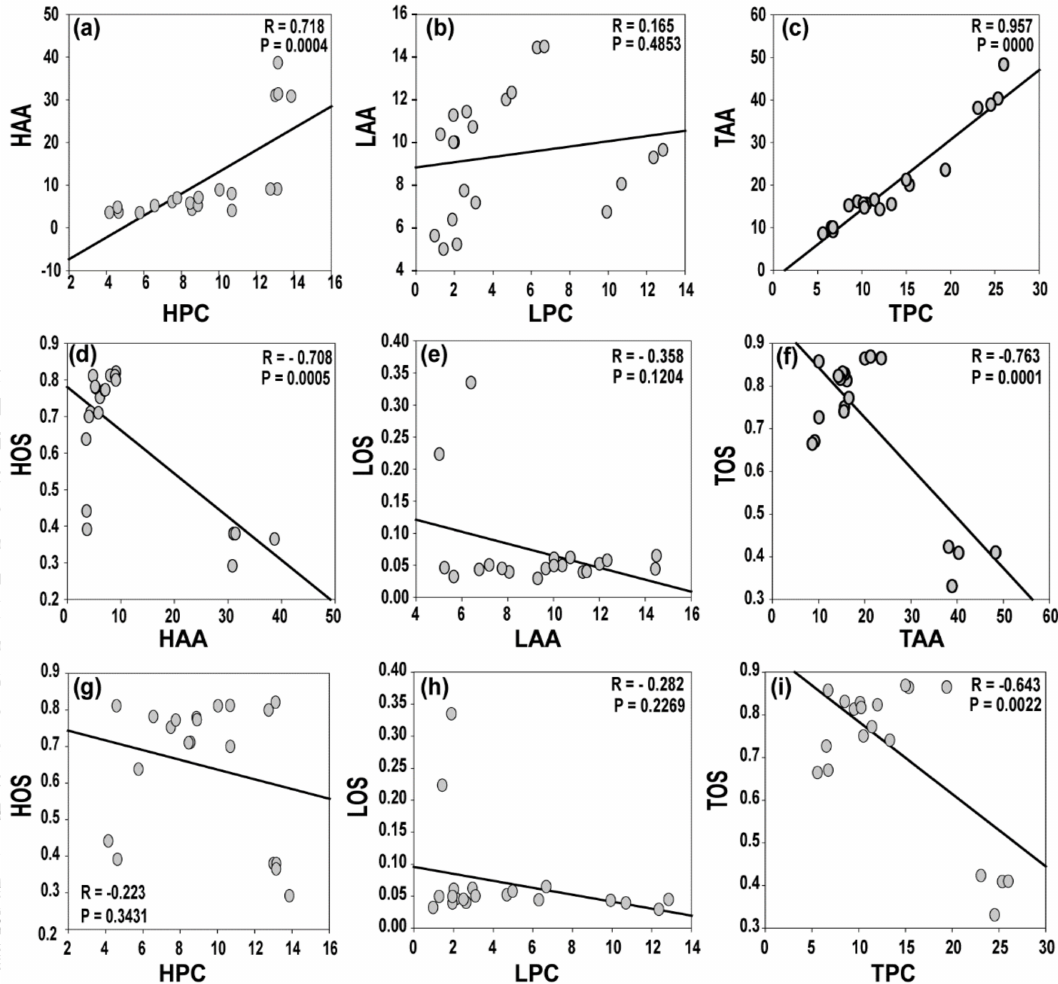
Figure 6. Scatter plots showing relationships between the phenolic content and antioxidant activities in natural soaps formulated with wild berry extracts following cold saponification ( a – c ). Scatter plots showing relationships between the antioxidant activities and oxidation status in natural soaps ( d – f ). Scatter plots showing relationships between the phenolic content and oxidation status in natural soaps formulated with berries following cold saponification ( g – i ). HPC = hydrophilic phenolic content, LPC = lipophilic phenolic content, TPC = total phenolic content, HAA = hydrophilic antioxidant activity, LAA = lipophilic antioxidant activity, TAA = total antioxidant activity, HOS = hydrophilic oxidant status, LOS = lipophilic oxidant status, TOS = total oxidant